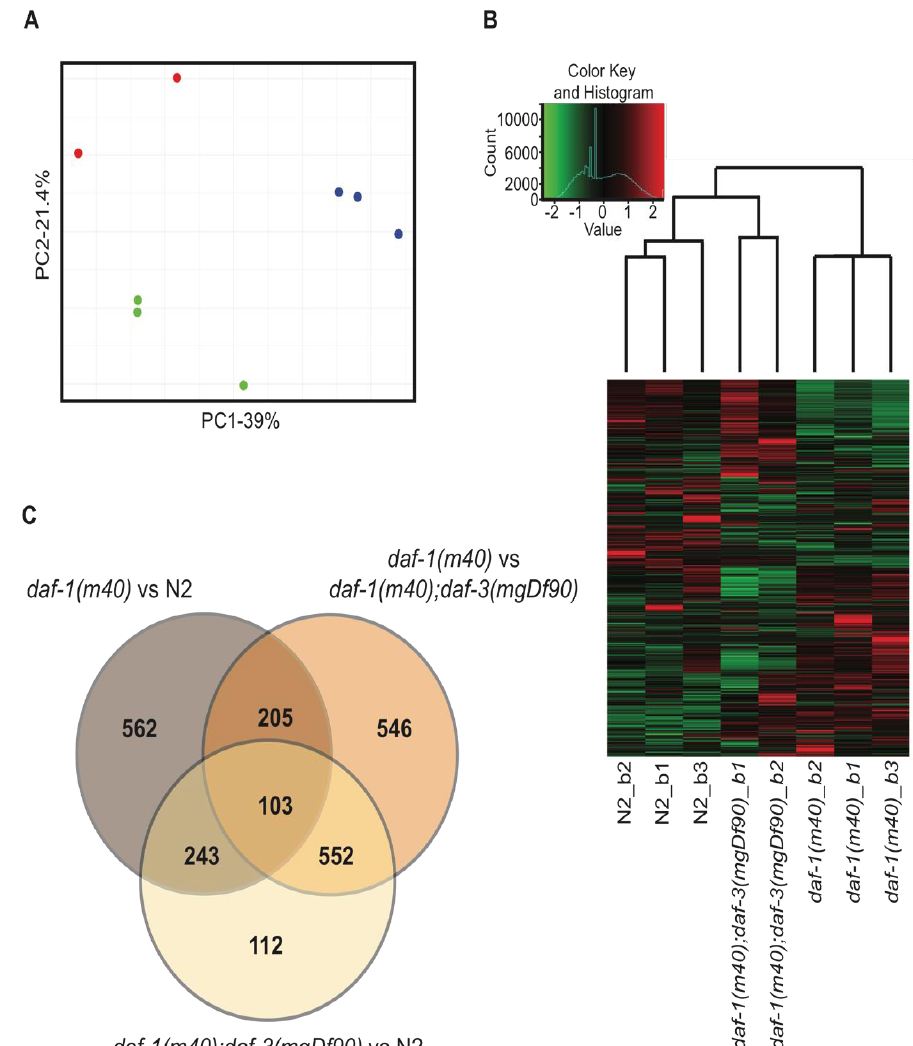
Figure 2. Description of the RNA-seq data. ( A ) Principle component analysis (PCA) of the sequenced samples. Red dots denote daf-1 ; daf-3 double mutants, blue dots denote daf-1 single mutants, and green dots denote wild-type N2. ( B ) The heatmap of the eight samples displayed in the PCA analysis ( A ). Samples are clustered hierarchically. Values on the x-axis of the color key denote relative z-scores. Count value on the y-axis denote the number of genes belonging to each z value on the x-axis. ( C ) Venn diagram of the di ff erentially expressed genes that are ≥ 2-fold di ff erence, q < 0.05 in daf-1 vs. N2, daf-1 vs. daf-1 ; daf-3 , and daf-1 ; daf-3 vs.